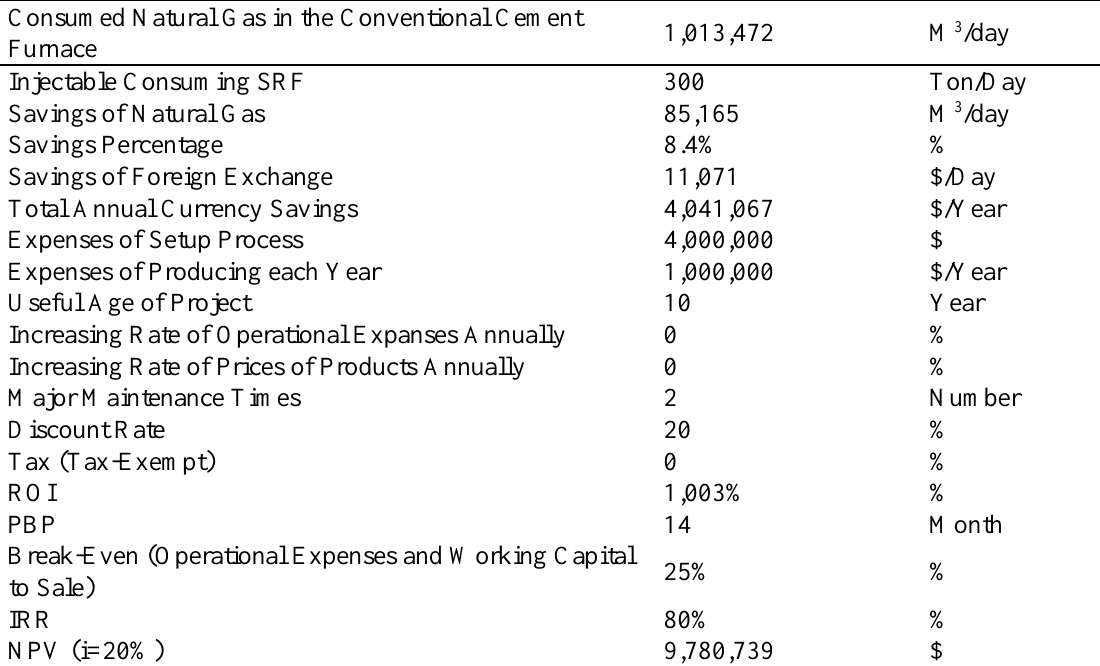
Table 7 . The Primary Economic